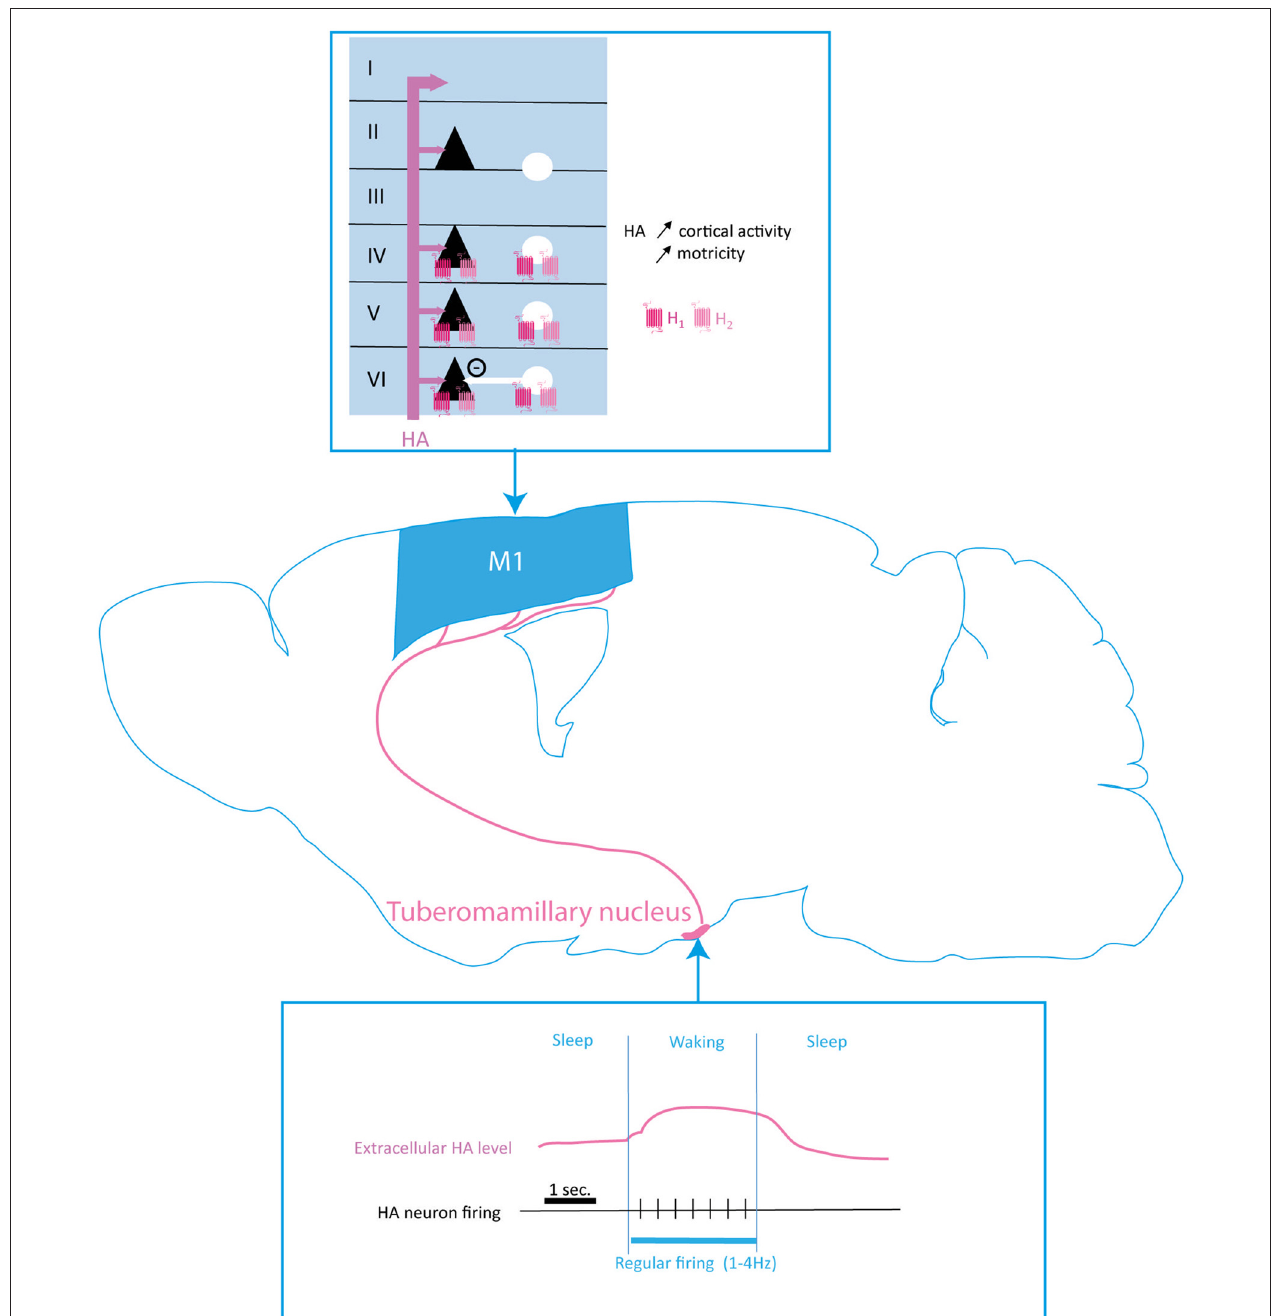
FIGURE 5 | Histaminergic modulation of the motor cortex function. Histamine (HA) input originates in the tuberomamillary nucleus (TMN) and projects to all M1 layers with higher fiber density found in layer I. HA firing and extracellular levels are correlated to sleep/waking rhythm, HA being released tonically during waking. H1 and H2 receptors are both expressed by projection neurons (black triangles) and interneurons (white circles). HA increases cortical activity and motricity. HA, histamine; PN, pyramidal neuron; IN,